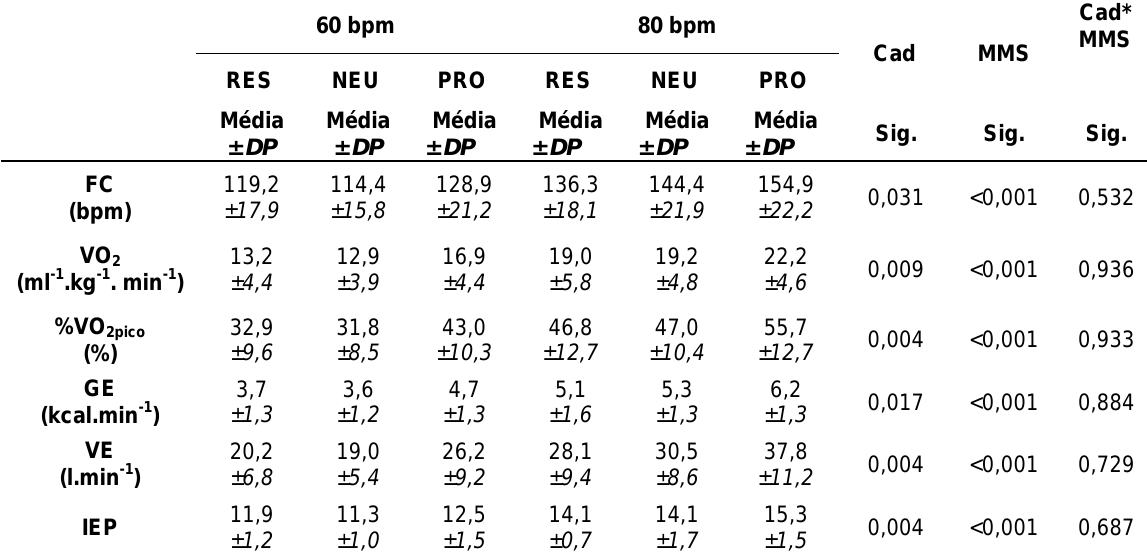
Tabela 2. Médias, desvios-padrão (DP) e significâncias (Sig.) dos efeitos principais cadência (Cad) e movimento de membros superiores (MMS) para as variáveis Freqüência Cardíaca (FC), Consumo de Oxigênio (VO ), % do Consumo de Oxigênio de Pico (%VO 2 Índice de Esforço Percebido